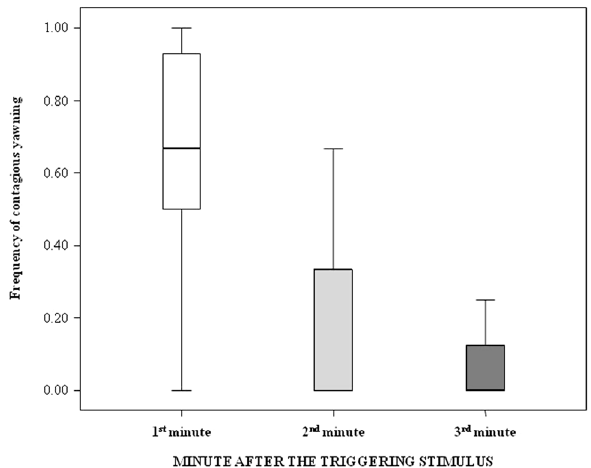
Figure 4. Box-plot showing the frequency of contagious yawning (Y axis) as a function of the minutes elapsing after the triggering stimulus (X axis). The difference across minutes is significant (Friedman’s test; N = 19, χ 2 = 19.279, df = 2, p < 0.001), with yawn contagion being significantly higher in the first minute than in other minutes (pairwise comparisons via Bonferroni–Dunn post-hoc test; first versus other minutes, 0.001 ≤ p ≤ 0.045). Solid horizontal lines indicate medians, length of the boxes corresponds to inter-quartile range and thin horizontal lines indicate minimum and maximum of the observed